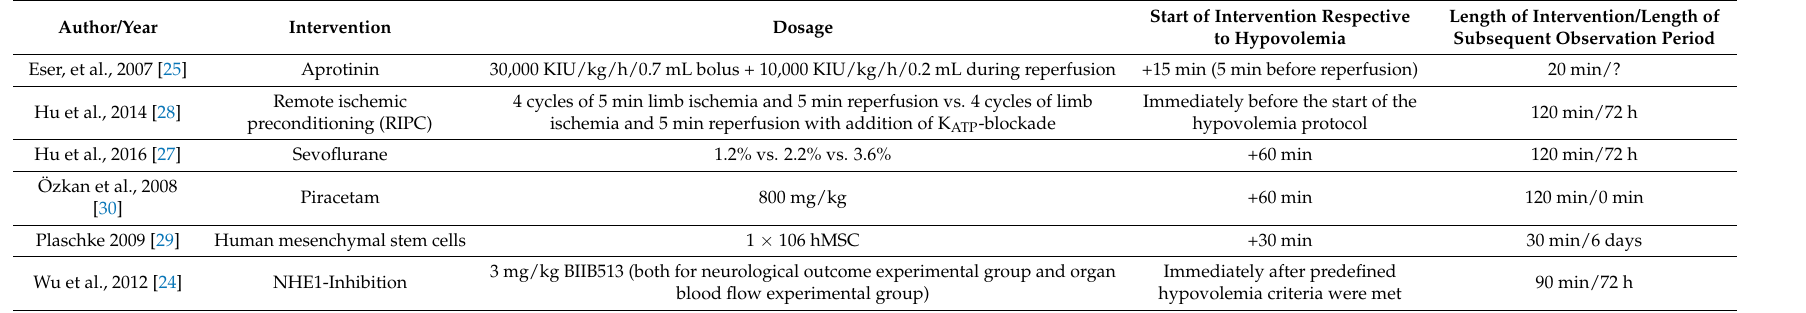
Table 4. Other neuroprotective strategies.